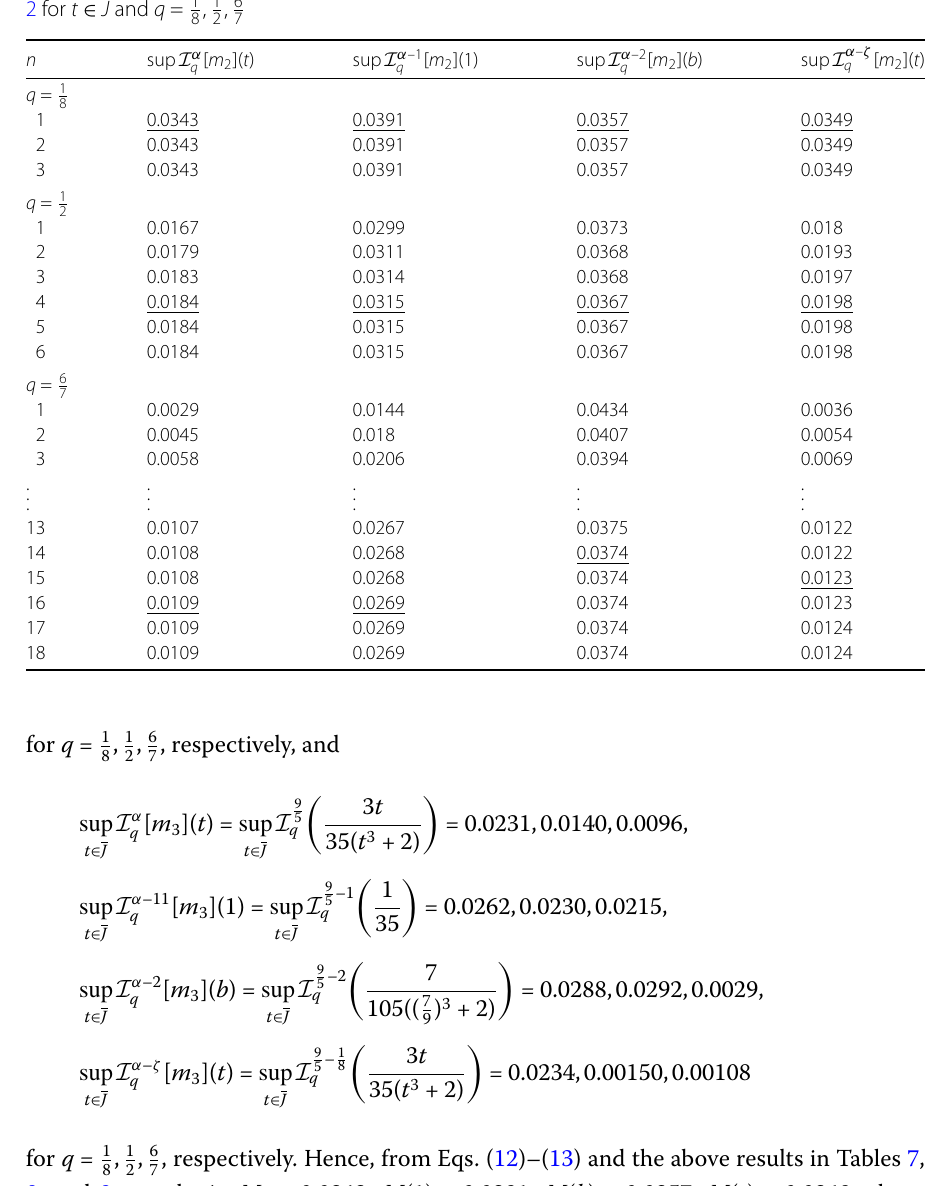
Table 8 Some numerical results of I α q [ m 2 ]( t ), I α –1 q [ m 2 ](1), I α –2 q [ m 2 ]( b ), and I α – ζ q [ m 2 ]( t ) in